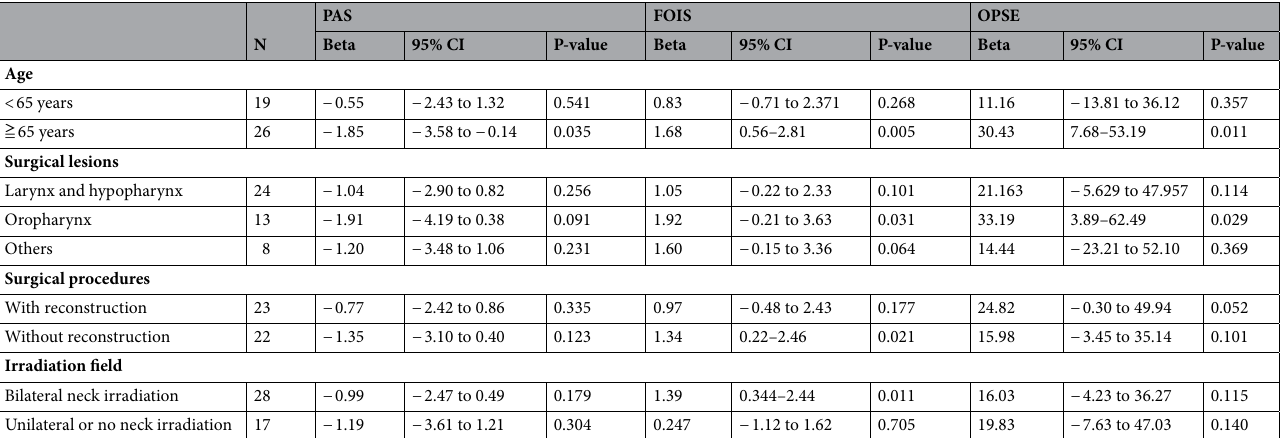
Table 5. Stratified analyses between the cross-sectional area of the geniohyoid muscle and PAS, FOIS and OPSE scores after surgery. N number of patients, PAS penetration aspiration scale, FOIS Functional Oral Intake Scale, OPSE oropharyngeal swallow efficiency, CI confidence